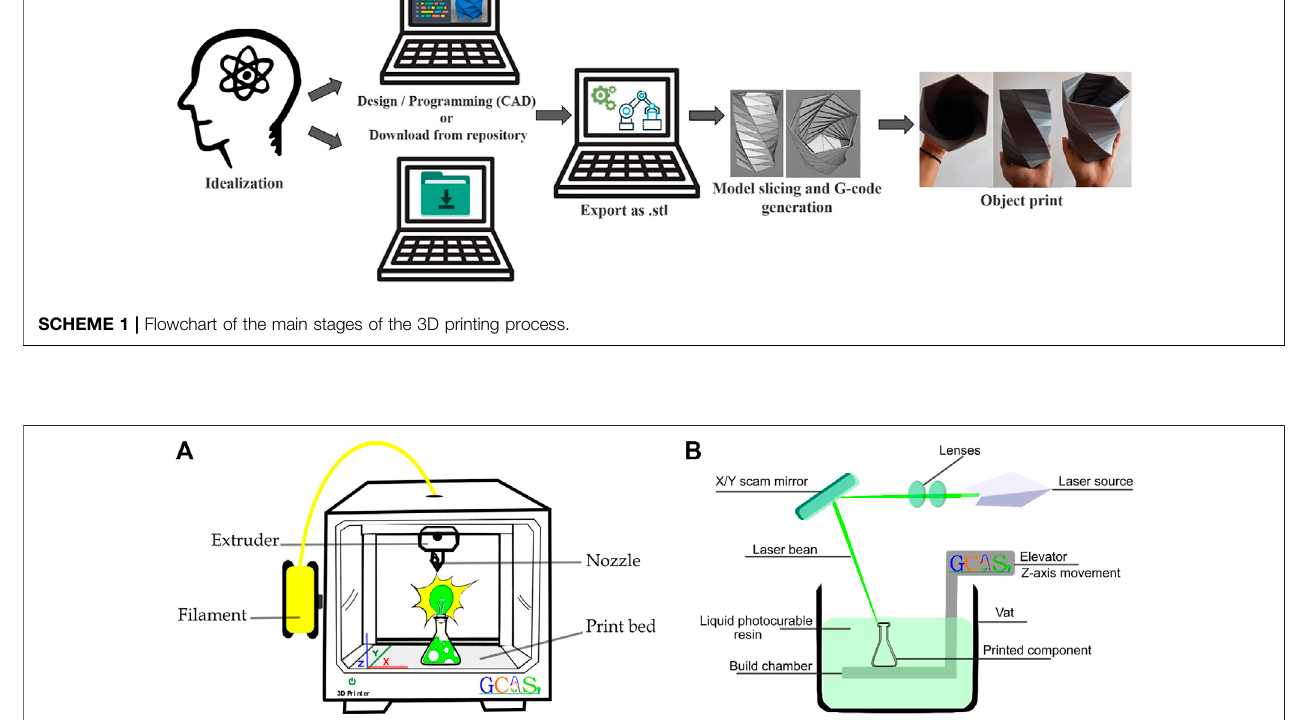
Frontiers in Chemistry |